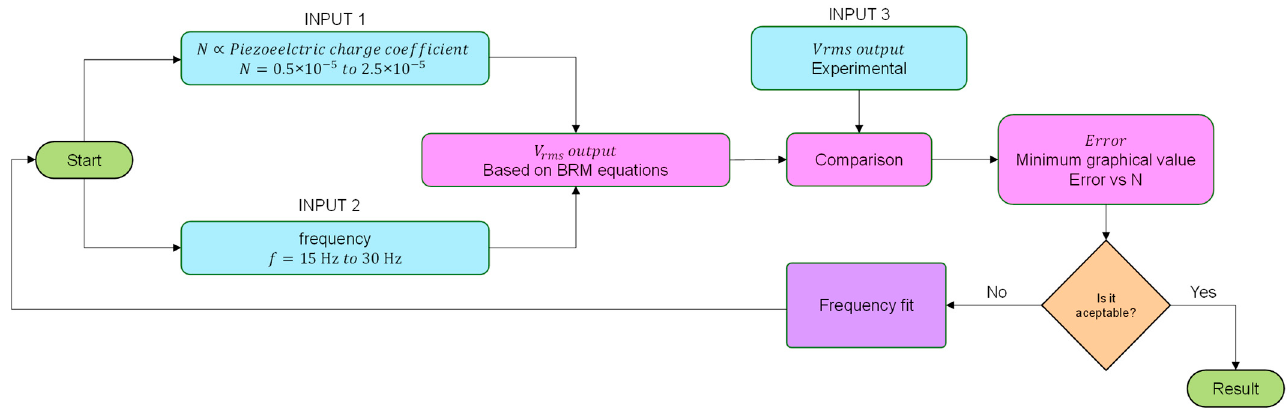
Figure 7. Scheme of the custom iterative algorithm.